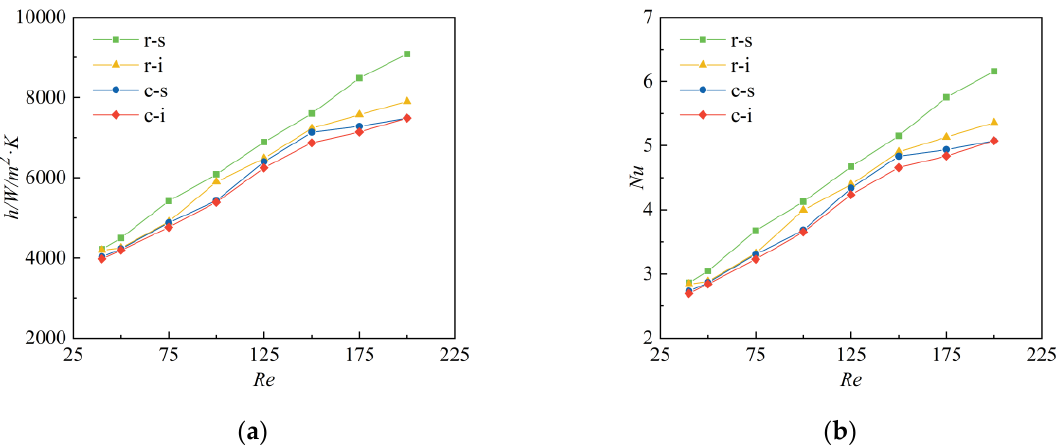
Figure 11. Heat transfer coefficient ( a ) and Nusselt number ( b ) in four types of micro-pin-fin array at different Re.